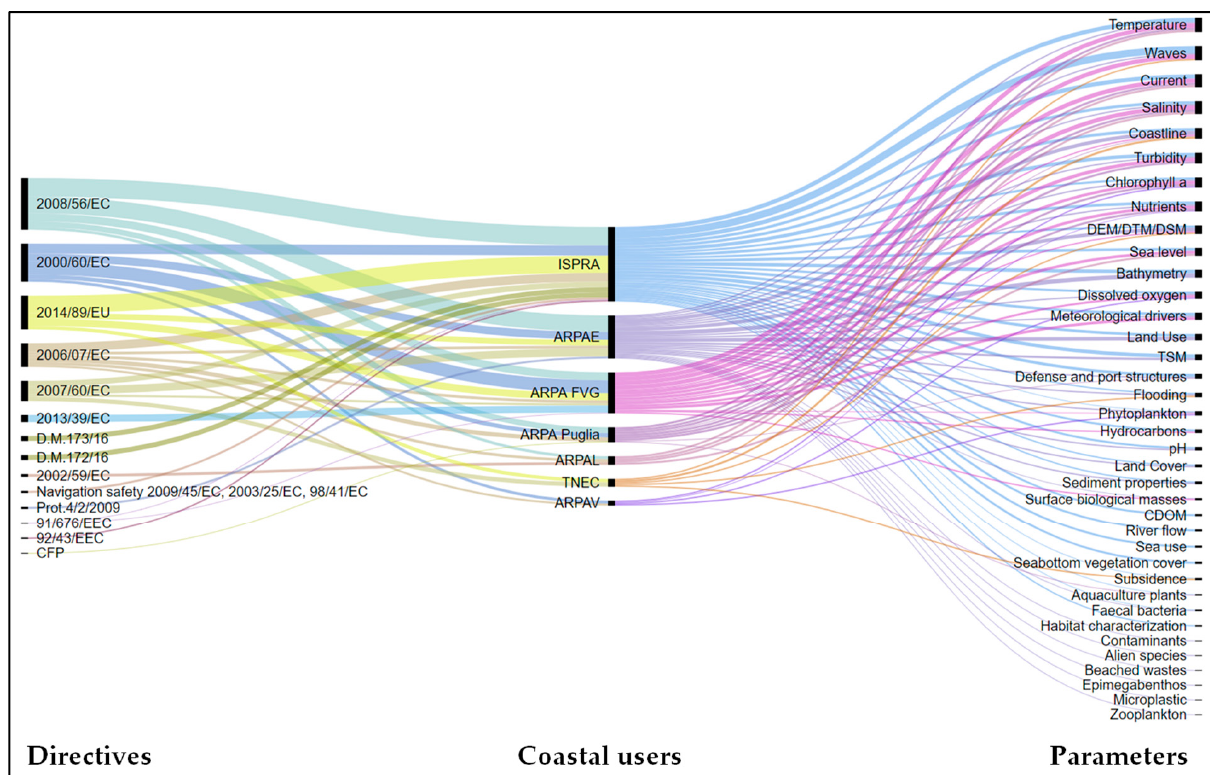
Figure 5. Sankey diagram representing the complexity of the connections between Directives (on the left ), Coastal users (in the middle ) and Parameters required by institutional users (on the right ).